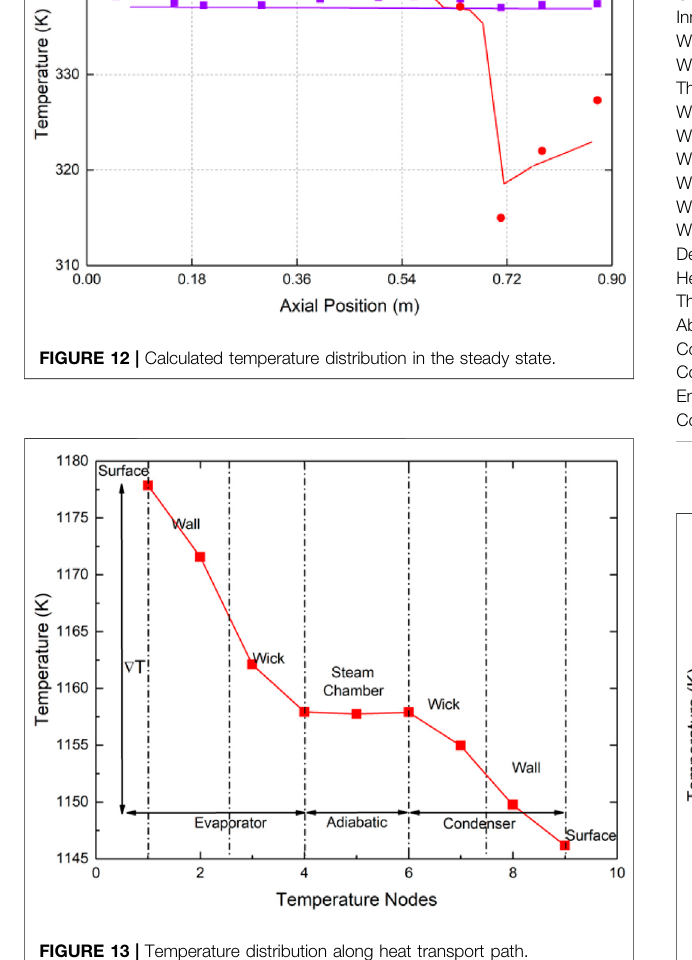
FIGURE 13 | Temperature distribution along heat transport path.